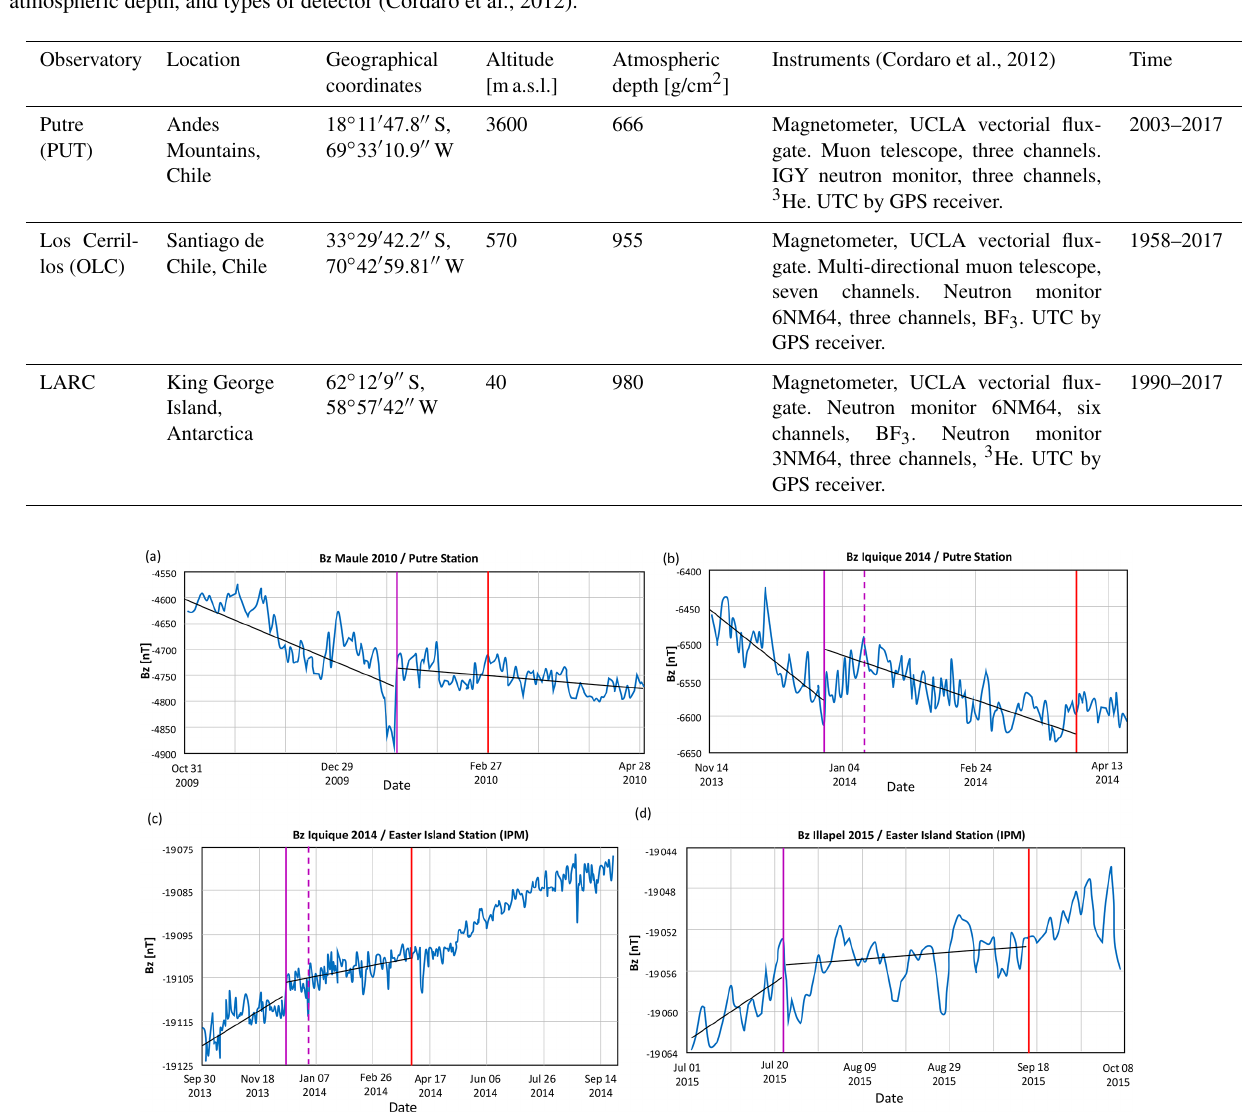
Figure 3. Vertical component B z as a function of time at Putre and IPM stations: (a) Maule 2010 at the Putre station, (b) Iquique 2014 at the Putre station, (c) Iquique 2014 at the Easter Island station, and (d) Illapel 2015 at Easter island station. Trend changes are observed in the four